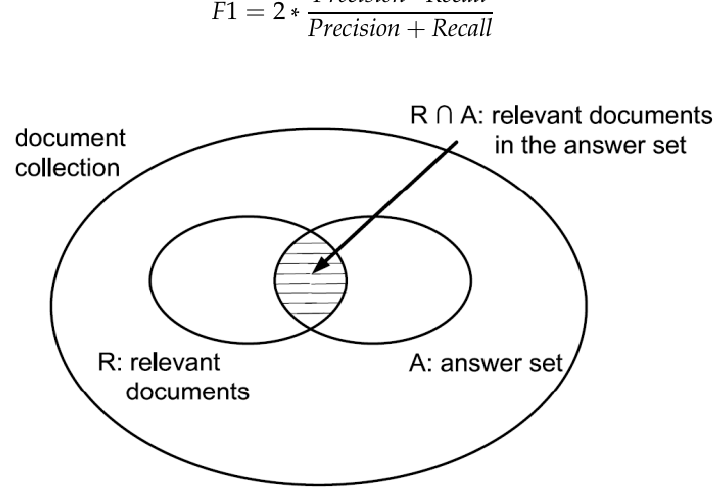
Figure 5. Performance evaluation measures.